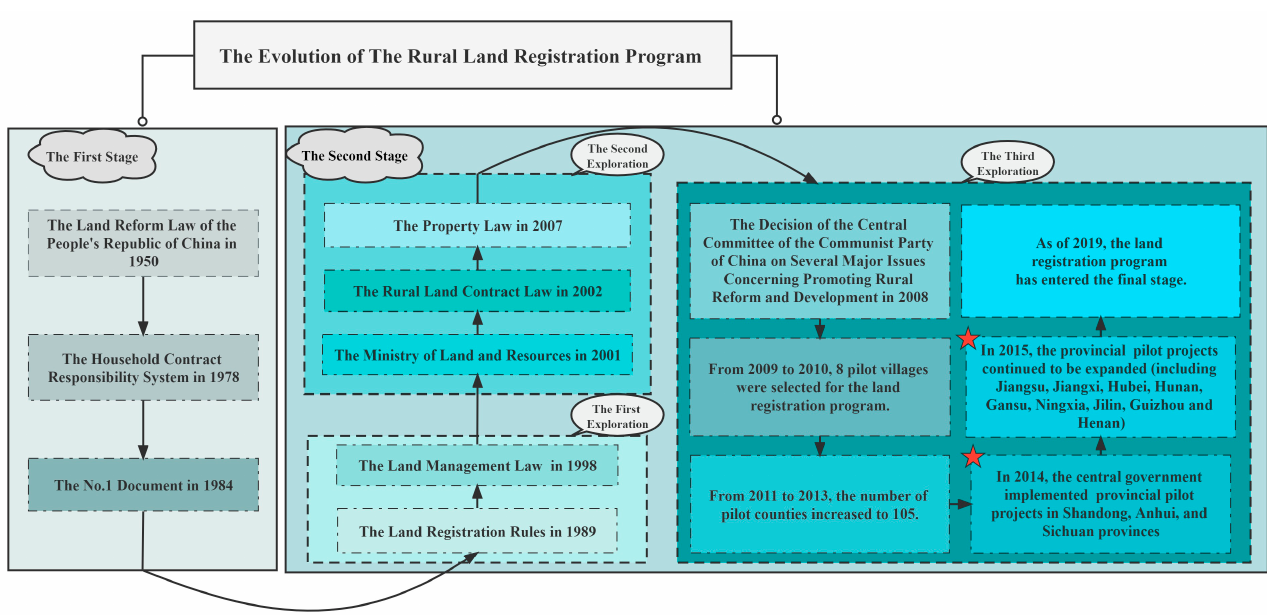
Figure 2. The evolution of the rural land registration program.